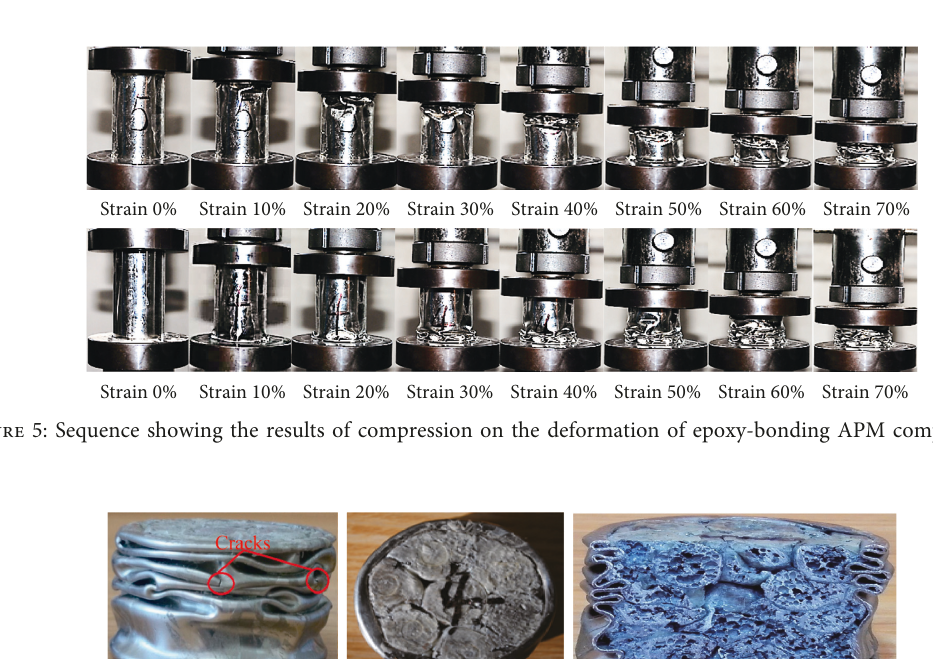
Figure 4: (a) Sequence showing the results of compression on the deformation of thin-walled pipes and (b) final morphology of the thin- walled pipe after